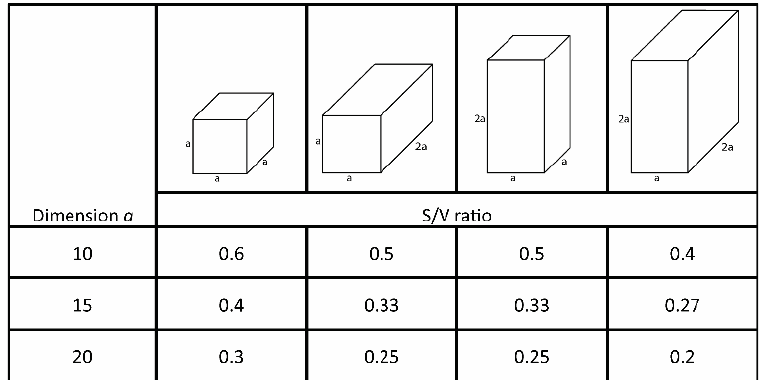
Figure 5. Exemplary values of surface to volume (S/V) ratio for different building shapes and sizes. Ratti et al. [59] advocated the use of a passive to non-passive zone ratio instead of the S/V ratio, where a passive zone is the floor area immediately next to the external building perimeter, equal (in buffer thickness) to twice the ceiling height; and the non-passive zone is the remaining inner floor area of the building. A passive zone is assumed to have a possibility to be passively daylit and ventilated, making it more energy efficient. The proposed zone ratio remains in conflict with the compactness advantage as understood by the S/V ratio